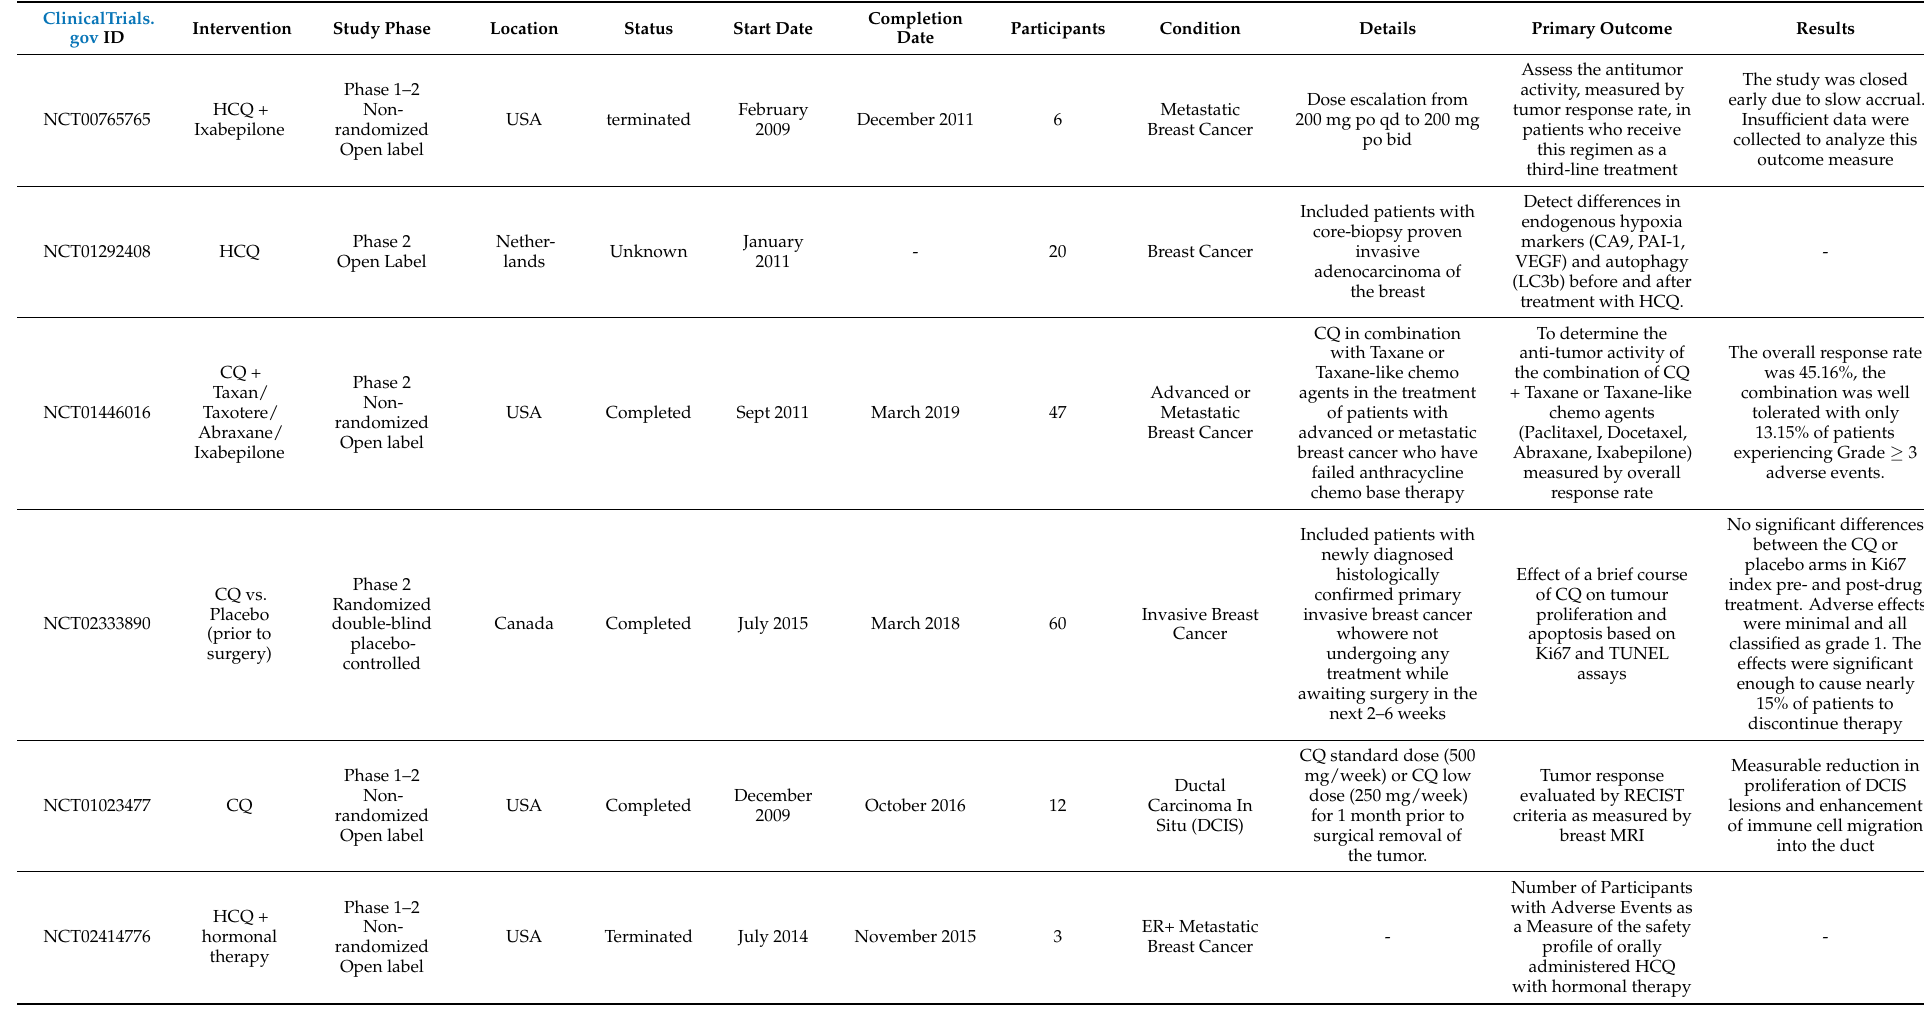
Table 1. Clinical trials evaluating monotherapy of HCQ/CQ or combined with anti-tumor drugs in breast